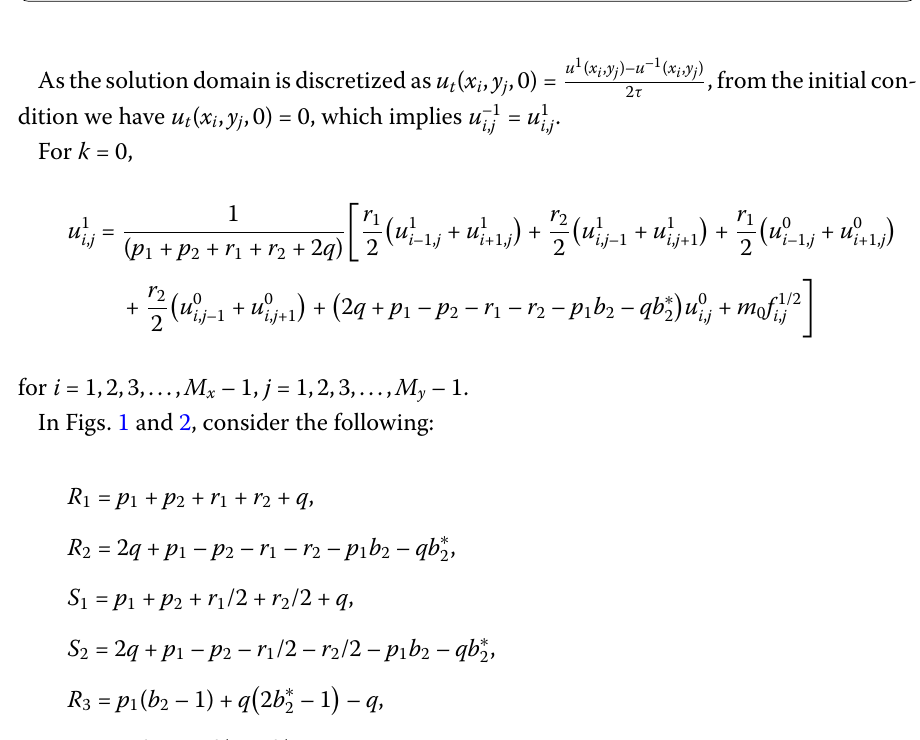
As the solution domain is discretized as u t ( x i , y j ,0) = u